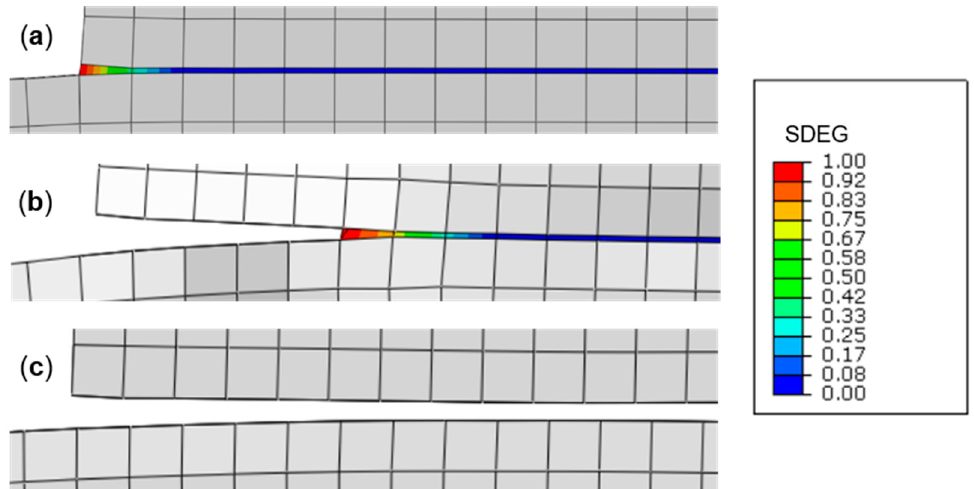
Figure 11. Progressive failure process of the adhesive layer in the lap-shear joint, ( a ) damage initiation at the overlap edges (SDEG-% = 0), ( b ) propagation towards the joint centre (SDEG-% ≈ 40), ( c ) joint failure (SDEG-% = 100).